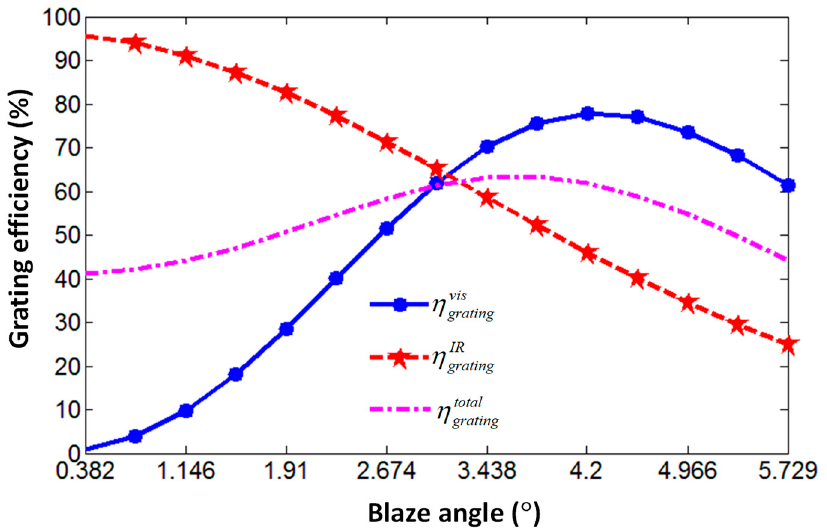
Figure 2. Relations between the grating efficiency and the blazed angle for different spectral bands.